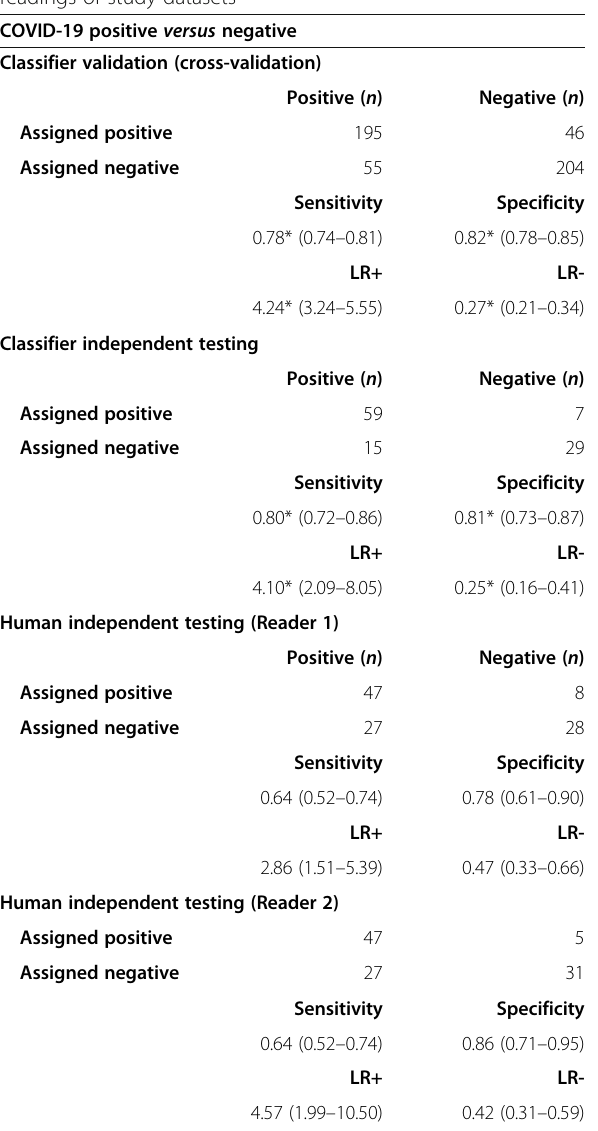
Table 2 Results for the deep learning classifier and human readings of study